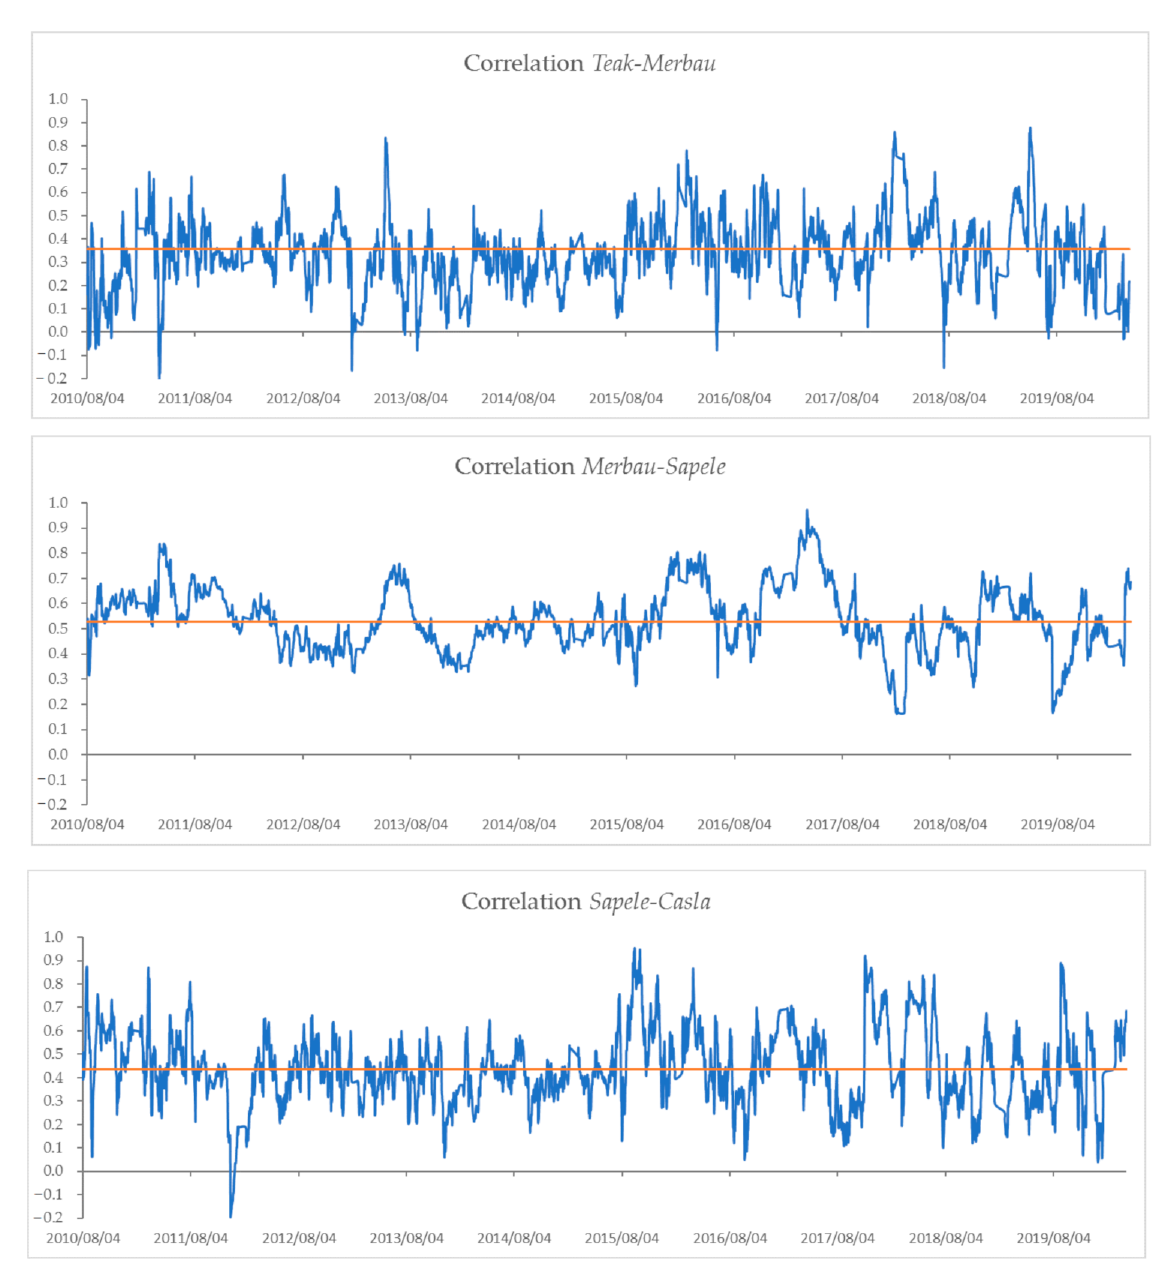
Figure 2. The dynamic conditional correlations of major hardwood lumber imported by China. Note: The dynamic conditional correlations are estimated with the DCC model. The solid lines are the constant conditional correlations on the grounds of Bollerslev